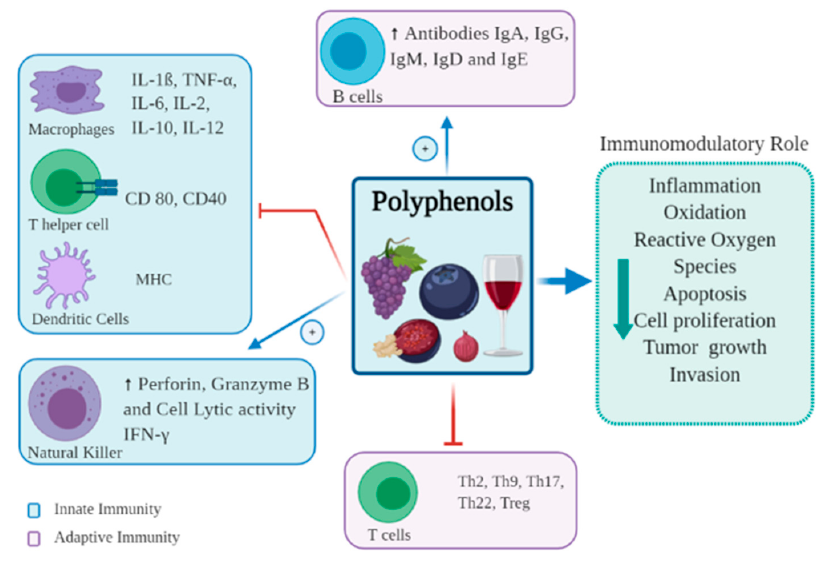
Figure 2. Immunomodulatory effects of polyphenols on immune cells.